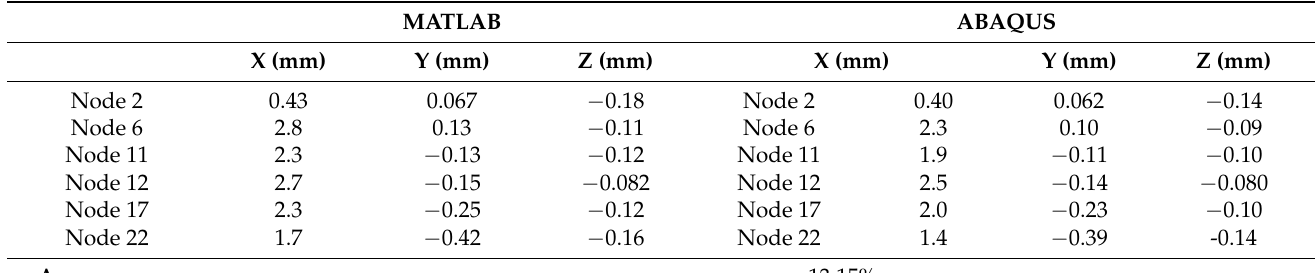
Table 1. Comparison of the nodal displacements from MATLAB and ABAQUS.